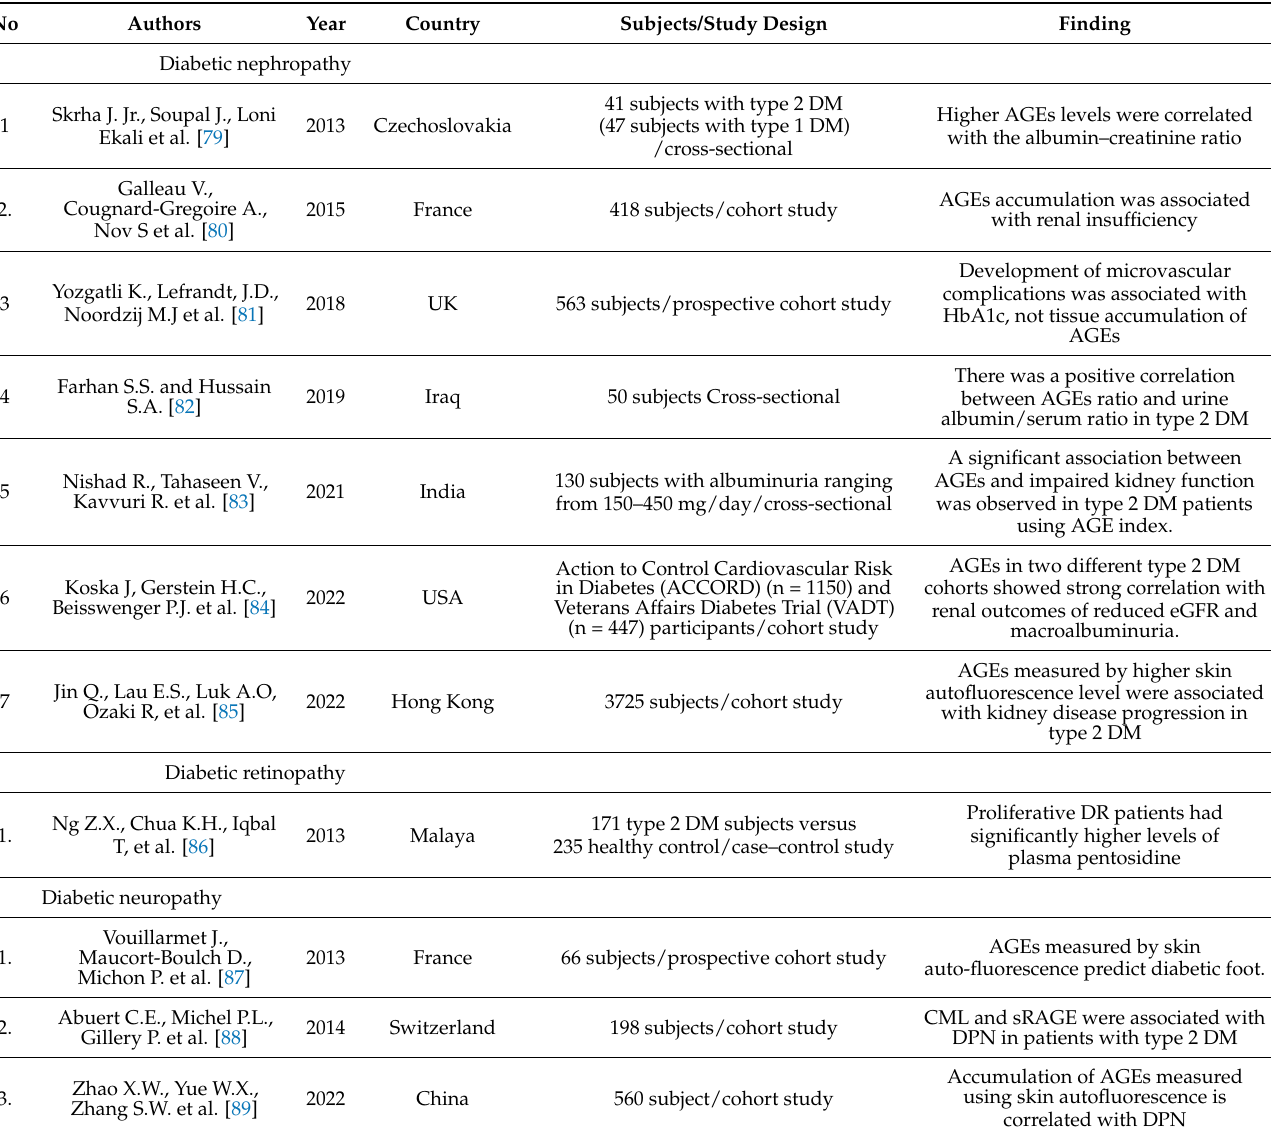
Table 1. Clinical studies—an association between microvascular complications and AGEs/RAGE in type 2 DM; Investigation of recent research within the past 10